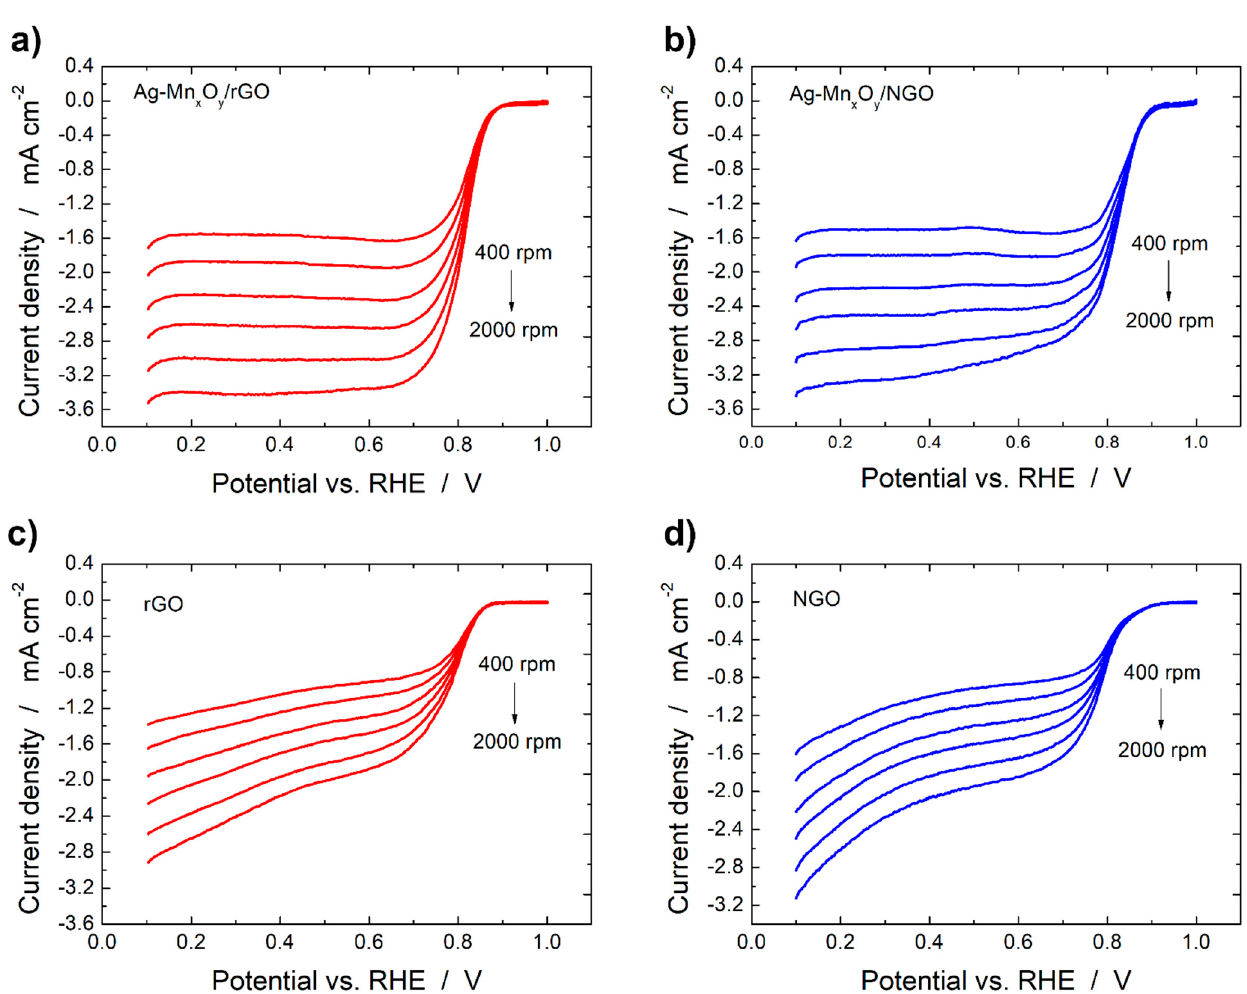
Figure 6. Potentiodynamic ORR curves of Ag-Mn x O y /rGO ( a ) and Ag-Mn x O y /NGO ( b ) catalysts as well as of rGO ( c ) and NGO ( d ) support materials in O 2 saturated 1 M KOH at 10 mV s − 1 at different rotation rates.